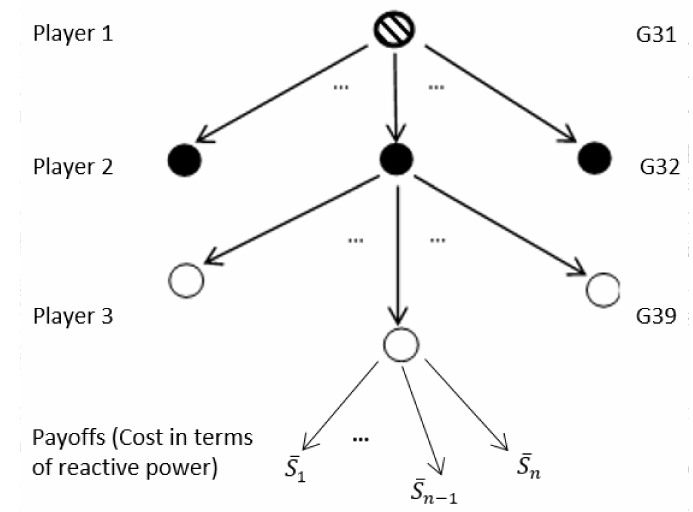
Figure 4. Extensive form game model for Area